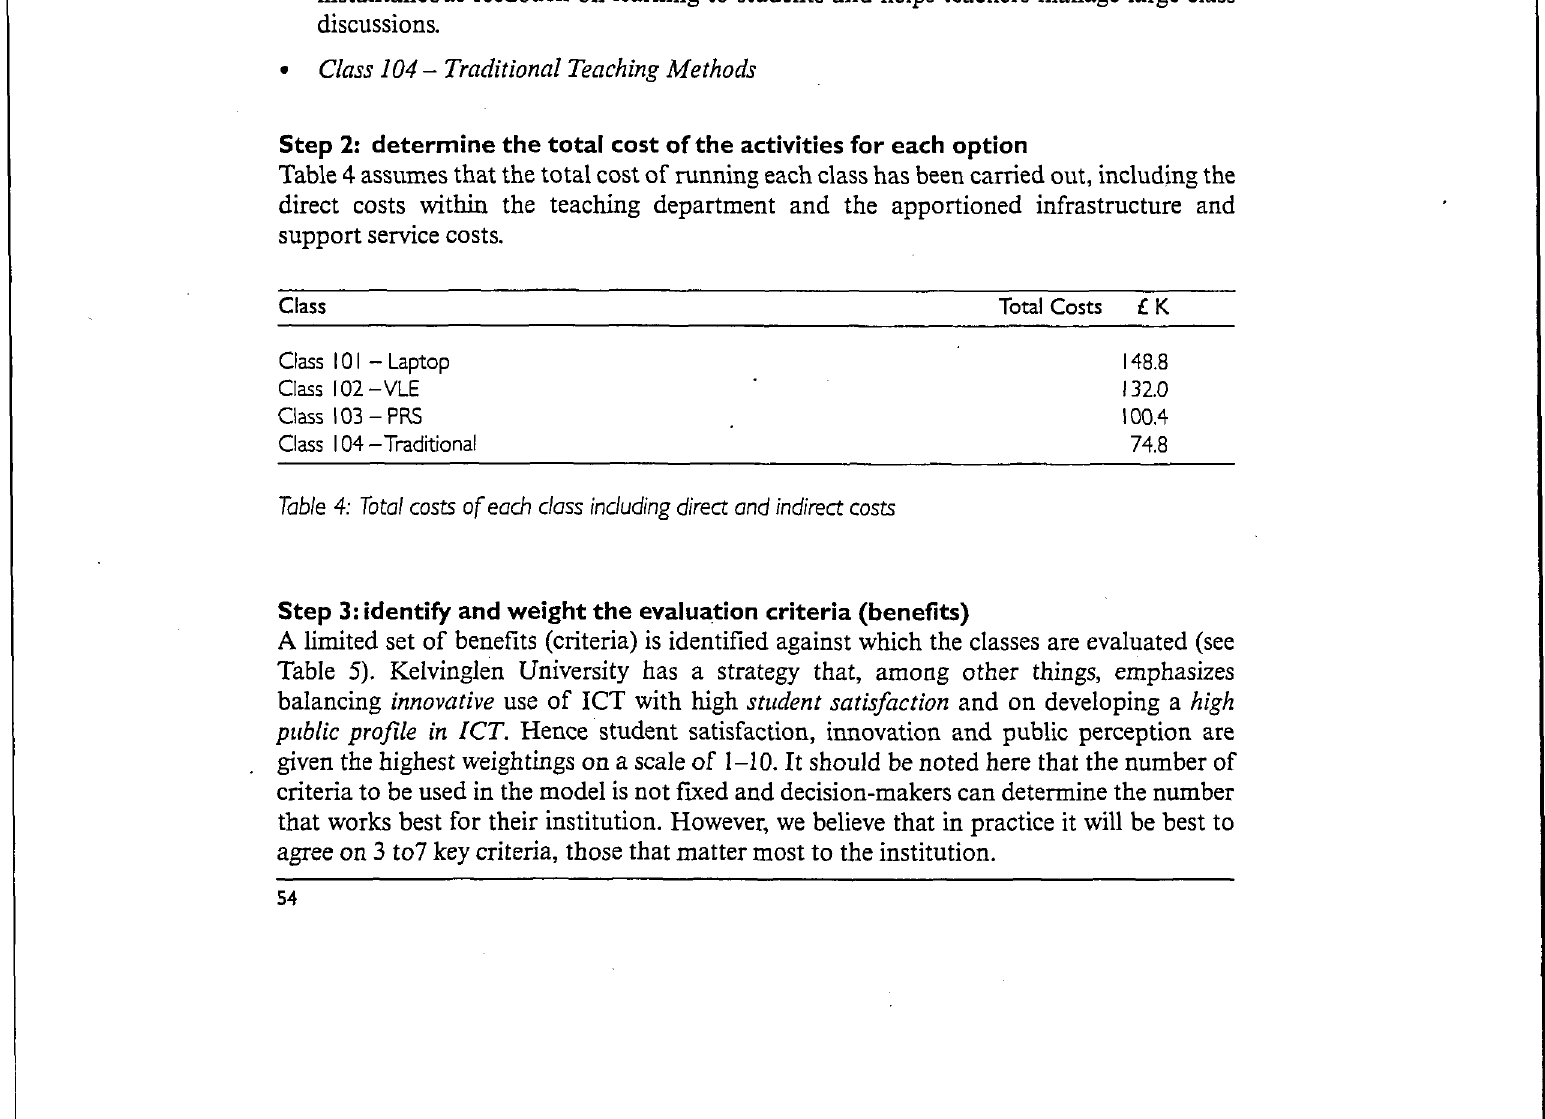
Table 4: Total costs of each class including direct and indirect